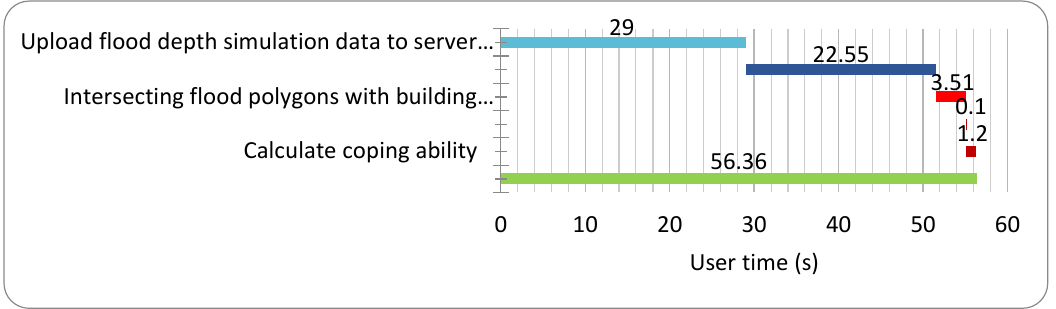
Figure 19. User time to calculate the loss of independence of vulnerable groups for a road network in Ghent resulting from a fluvial flood event (return period 1000 years) with a raster approach (5 m resolution).